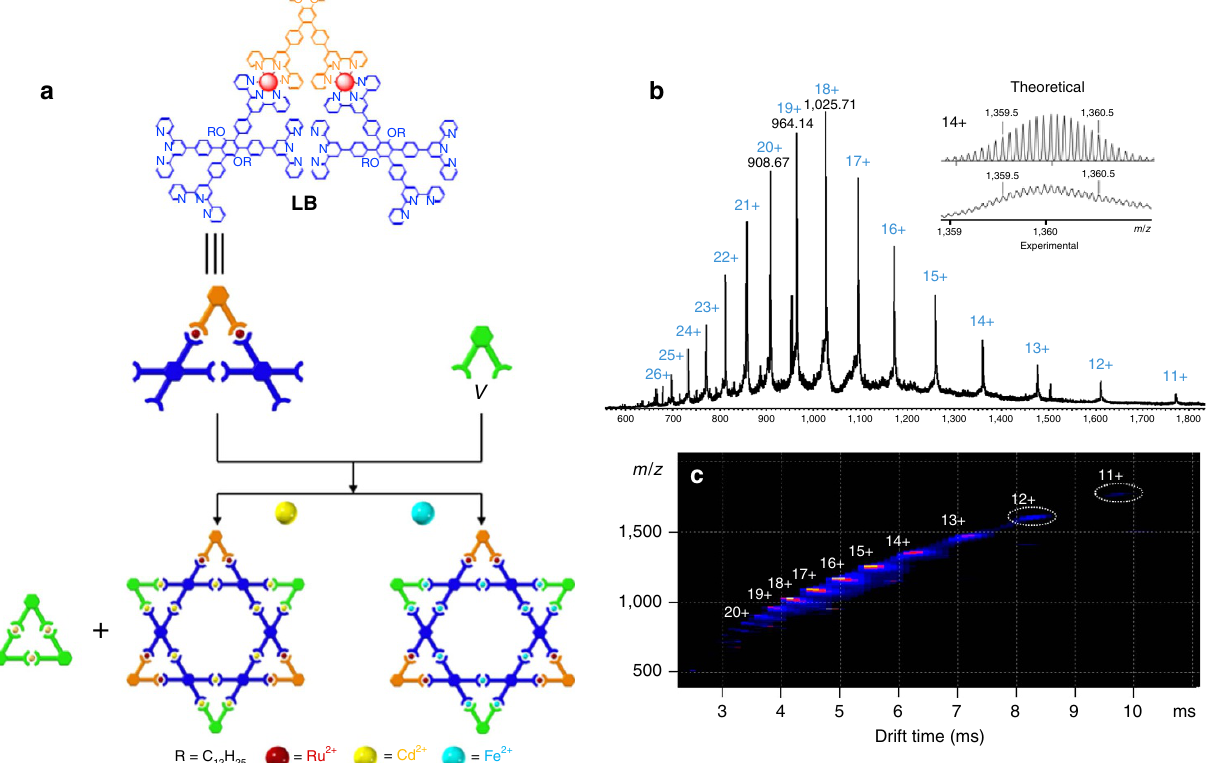
Figure 5 | Self-assembly of supramolecular hexagram [Fe 12 V 3 LB 3 ] 36 þ . ( a ) Schematic illustration of synthesizing molecular Star of David by using metallo-ligand LB , V and metals. ( b ) ESI-MS and ( c ) TWIM-MS of